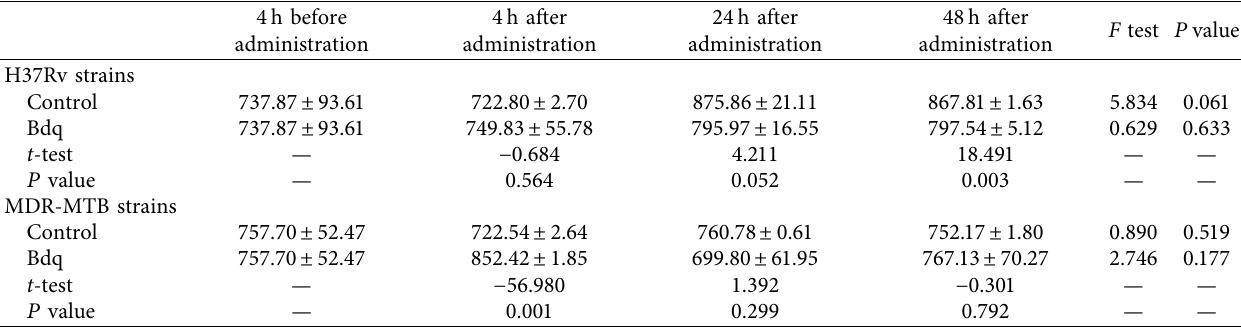
Table 3: Levels of IL-12/23 p40 in culture supernatants of macrophages infected with H37Rv and MDR-MTB strains after Bdq ad- ministration (pg/ml, x ± s ).